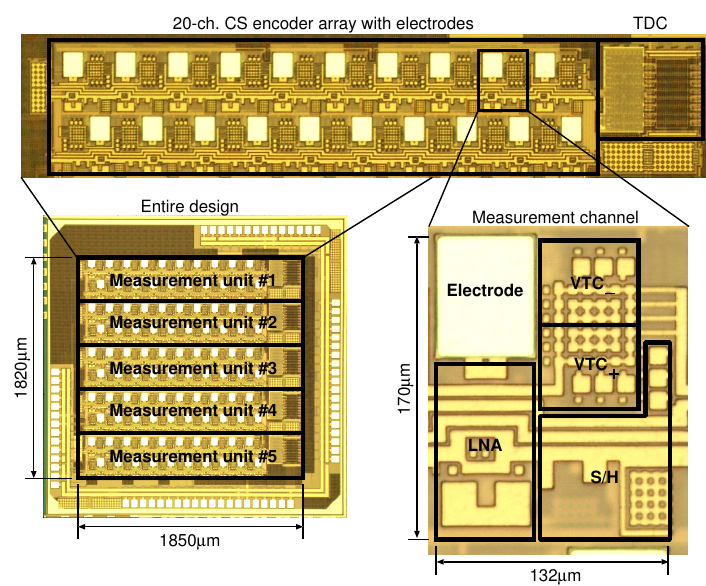
Figure 14. Chip microphotograph of the proposed time-domain analog CS encoder prototype.